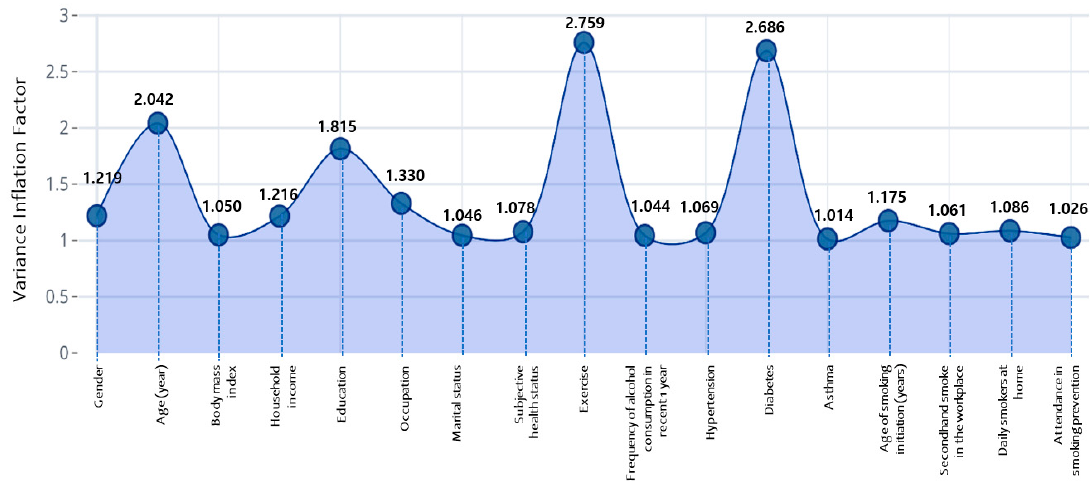
Figure 2. Results of the variance inflation factor analysis on the selected features.